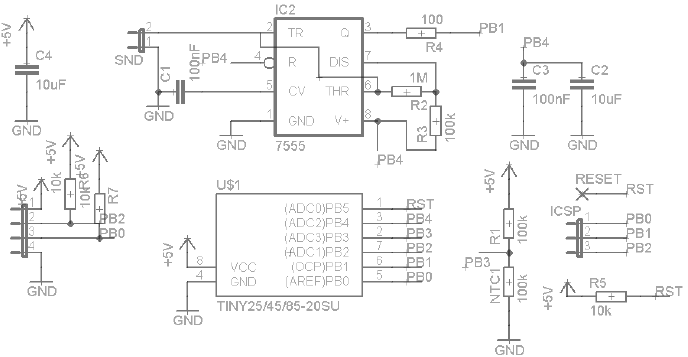
Figure 24. The probe with the ATiny25 microcontroller.